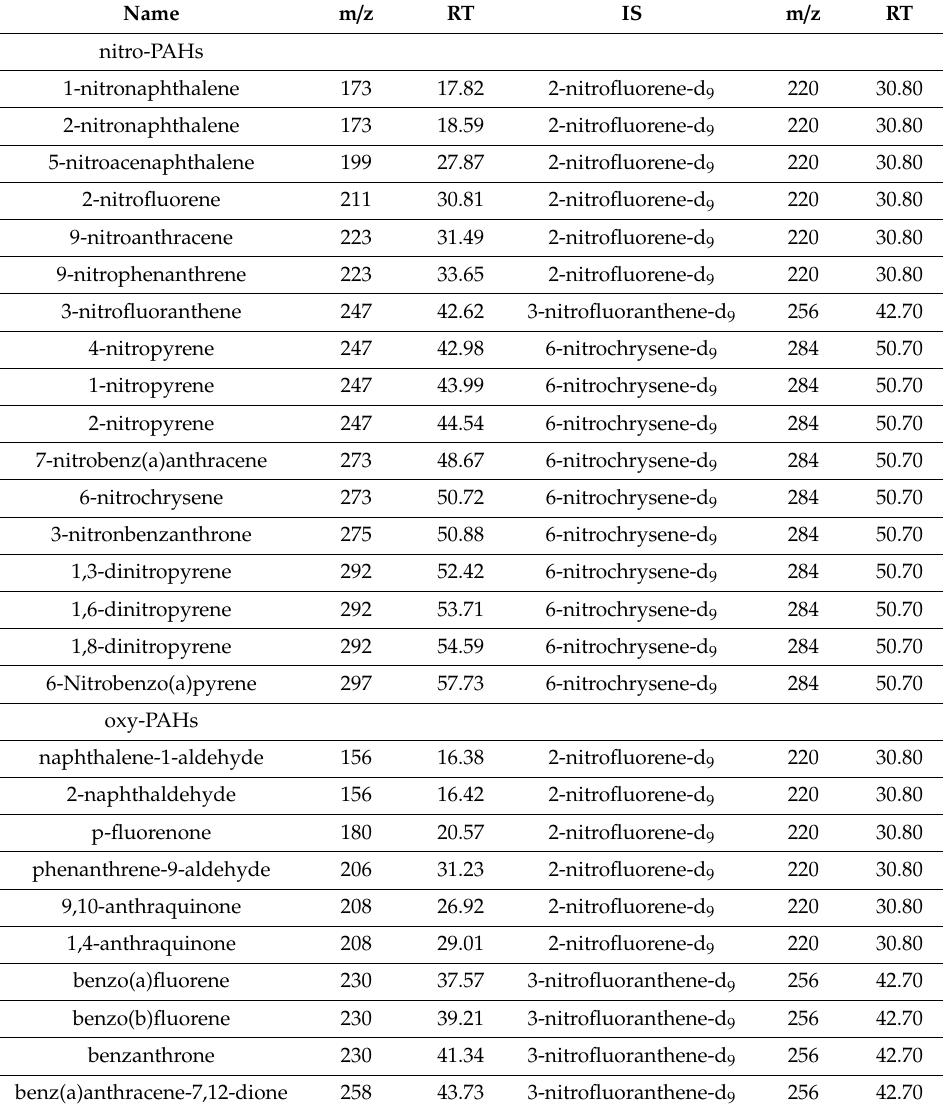
Table A3. Transitions and retention times of nitrated (nitro-PAH) and oxygenated (oxy-PAH) PAHs and deuterium labeled internal standards (IS) and recovery standard (RS) used. Analysis was performed using capture negative chemical ionisation mode